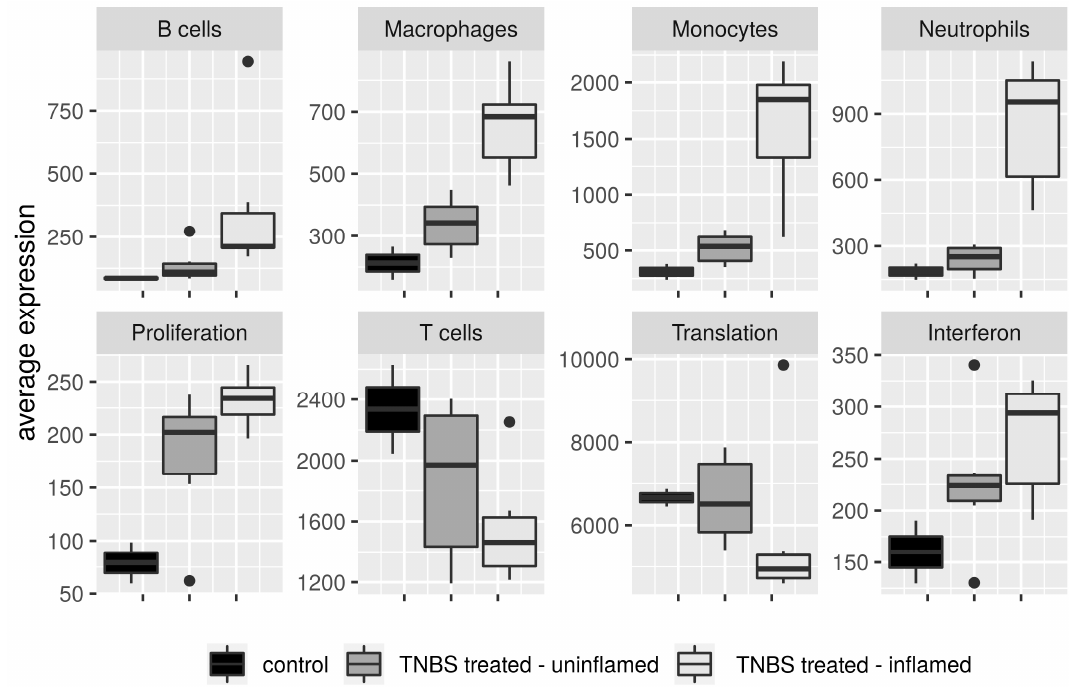
Figure 6. Immune cell composition of colon tissues from in vivo model of IBD. Average expression of immune signature genes of B cells, macrophages, monocytes, neutrophils and T cells, and pathway signature genes of Interferon, Proliferation and Translation categories between control, TNBS-treated uninflamed and TNBS-treated inflamed rat colon samples.